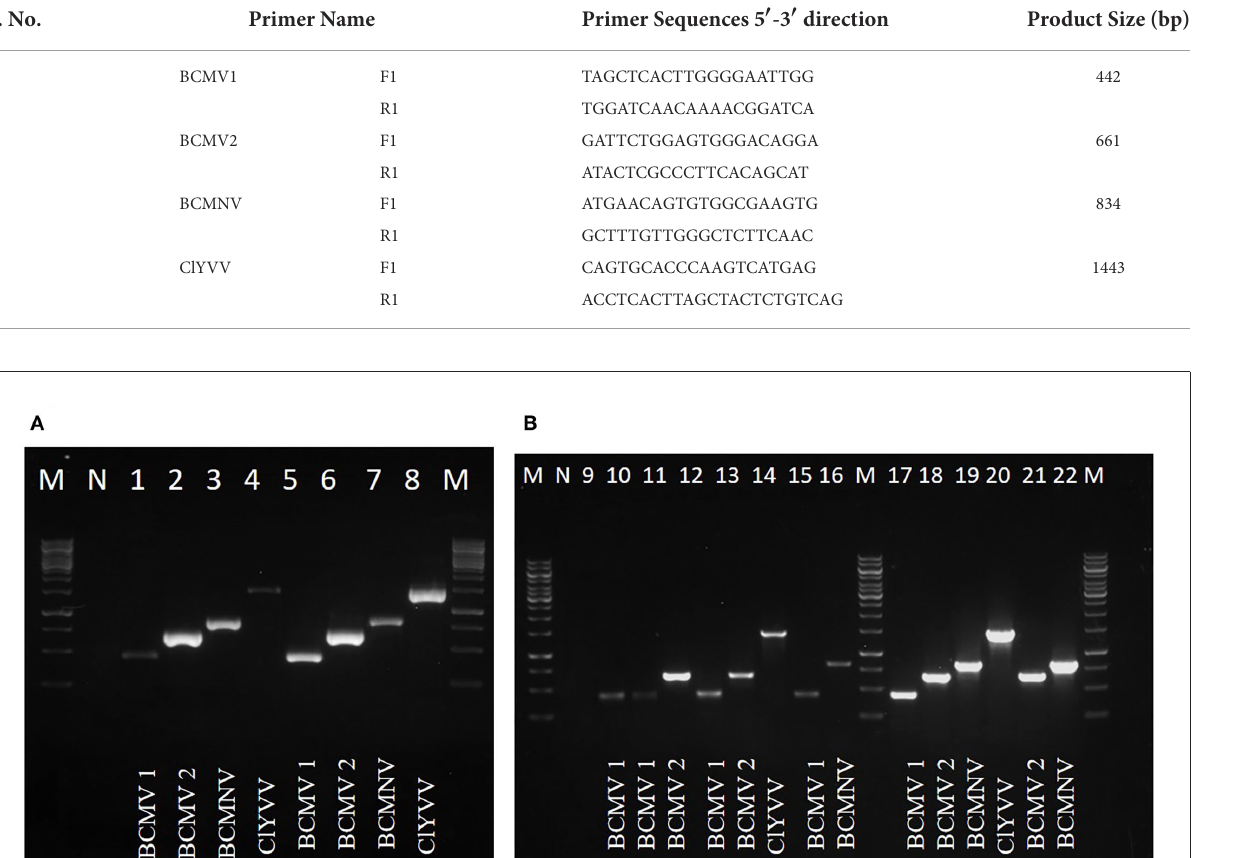
TABLE 2 Primer designed and used in the present study.